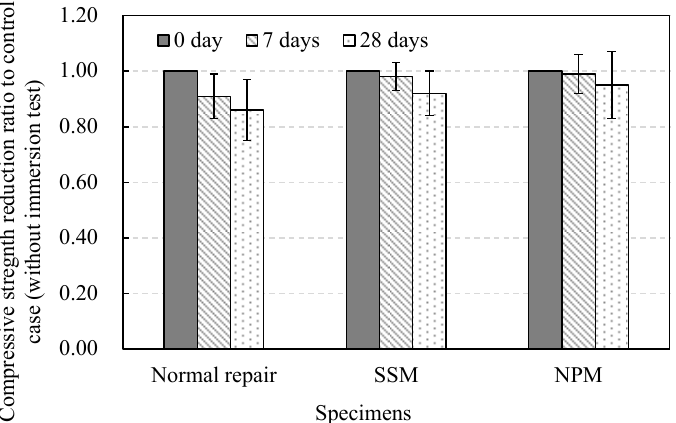
Figure 8. Compressive strength variation of the coated concretes immersed in 5% sulfuric acid